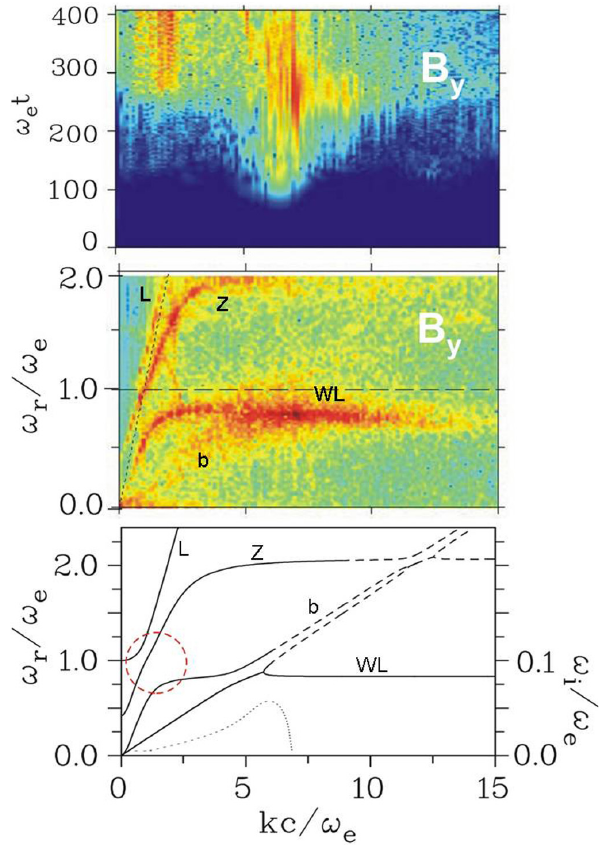
Fig. 14. Spatial profile of the magnetic field component B y at ω e t = 400 for the same run as in Fig. 13. The lower plot shows a wave packet with an extension of about 12 c/ω e which con- sists of the short-scale beam-excited wave with a wave length of λ ∼ 0 . 9 c / ω e , in good agreement with the value following from the resonance condition kc/ω e ∼ c/V b ( V b /c = 0 . 15). The average ex- tension of the wave packet itself is well related to the wave number of the corresponding Gendrin mode, kc/ω e < 1; see Fig.